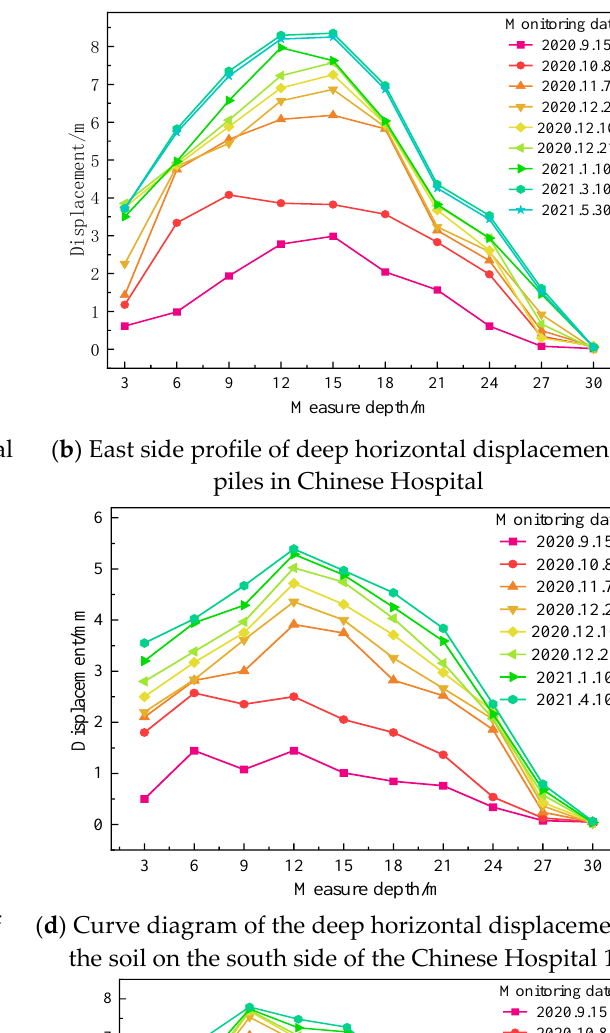
( a ) Curve diagram of the east gate of the deep horizontal ( b ) East side profile of deep horizontal displacement of